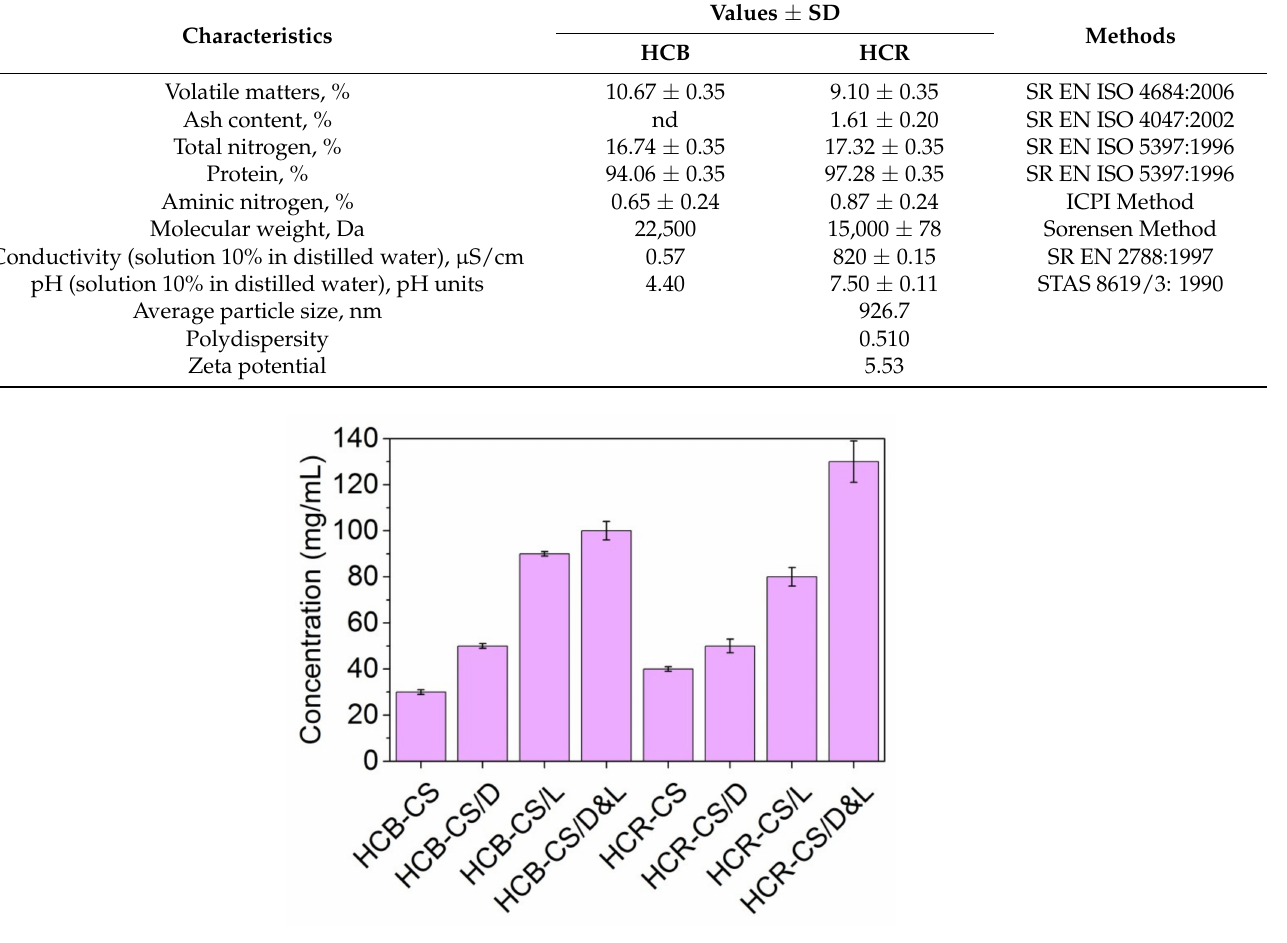
Table 3. Characteristics for hydrolyzed collagen from bovine tendons (HCB) and rabbit skins (HCR) in powder form [23]. Characteristics